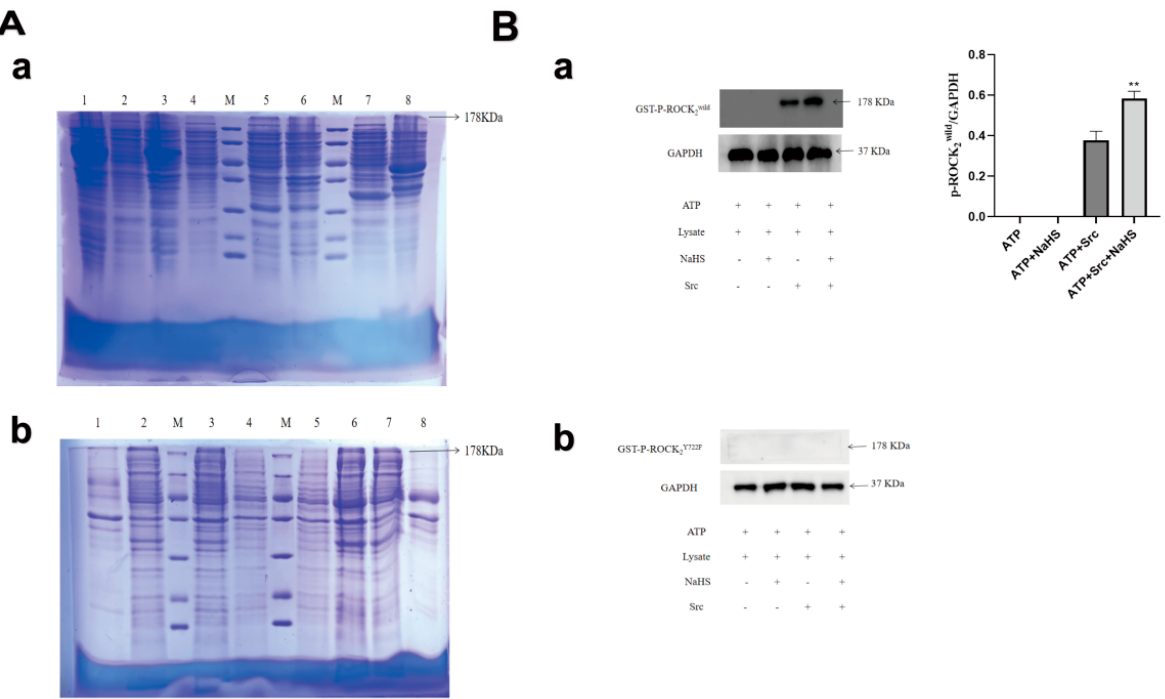
Figure 1. Expressions of GST-ROCK 2wild and GST-ROCK 2Y722F in E. coli , and effects of NaHS on their phosphorylation in vitro. ( A ) Coomassie brilliant blue staining assay. ( a ): M: marker, 1–2: induced lysate supernatant and precipitate of the empty E. coli , 3–4: induced lysate supernatant and precip- itate of the empty plasmid transfected E. coli . 5–6: uninduced lysate supernatant and precipitate of the ROCK 2wild -pGEX-6P-1-transfected E. coli , 7–8: uninduced lysate supernatant and precipitate of the ROCK 2Y722F -pGEX-6P-1-transfected E. coli. ( b ): M: marker, 1–2: induced lysate precipitate and supernatant of the ROCK 2wild -pGEX-6P-1-transfected E. coli , 3–4: induced lysate supernatant and precipitate of the ROCK 2Y722F -pGEX-6P-1-transfected E. coli, 5–6: induced lysate precipitate and su- pernatant of the ROCK 2wild -pGEX-6P-1-transfected E. coli with RIPA, 7–8: induced lysate precipitate and supernatant of the ROCK 2Y722F -pGEX-6P -1-transfected E. coli with RIPA. ( B ) Effect of NaHS on phosphorylation of ROCK 2 at Tyr722 in vitro (Western blot assay, mean ± SEM, n = 3). ATP: 100 μ mol/L, Lys: 15 μ L, NaHS: 100 μ mol/L, Src: 100 ng. ( a ): in the lysate of the ROCK 2wild -pGEX-6P-1- transfected E. coli ; ( b ): in the lysate of the ROCK 2Y722F -pGEX-6P-1- transfected E. coli . ** p < 0.01 vs. ATP + Src group.